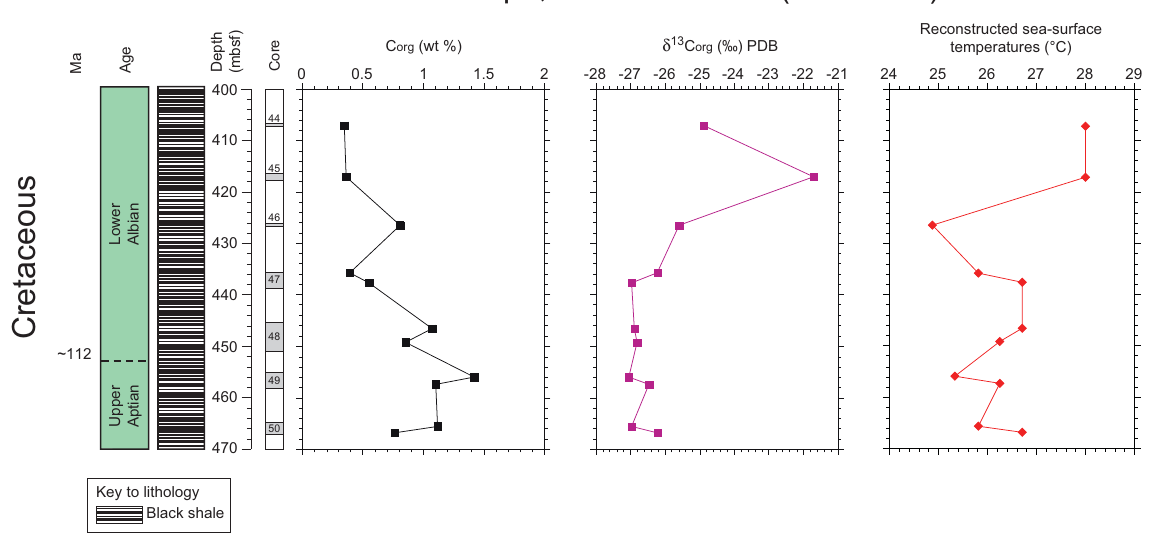
Fig. 2. Geochemical and palaeotemperature data from ODP Site 693 on the Antarctic shelf. Total Organic Carbon (TOC) values mostly lie in the 0.5–1.5wt% range; the carbon-isotope values, including the positive excursion, are compatible with the biostratigraphically assigned Aptian-Albian age. Palaeotemperature data, determined using the Kim et al. (2010) calibration, suggest sea-surface temperatures mostly in the 24–28 ◦ C range. Approximate absolute ages after the time scale of Ogg et al.